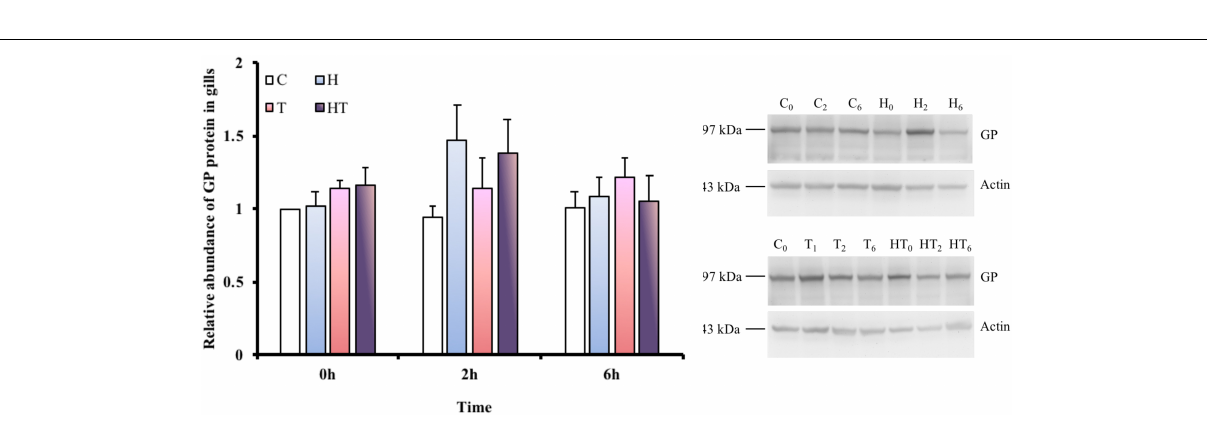
FIGURE 4 | Relative abundance of GP protein was found at approximately 97 kDa in M. opercularis in control (C), hypoxic (H), thermal (T), and hypoxic-and-thermal (HT) treatment groups at 0, 2, and 6 h ( n = 7–9). All GP protein expression of fish were showed by their relative value to C treatment at 0 h. There were no statistically significant differences among treatments and times. Data are presented as mean ±